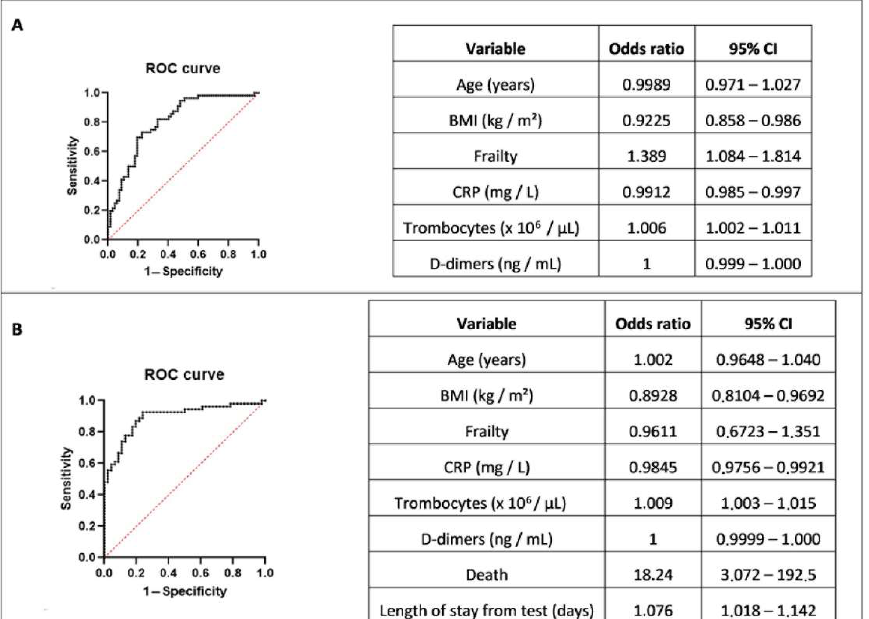
Figure 1. Multiple logistic regression modelling of HAI versus CAI patients. ( A ) Multiple logistic regression without death and length of stay variables. ( B ) Multiple logistic regression with death and length of stay variables.